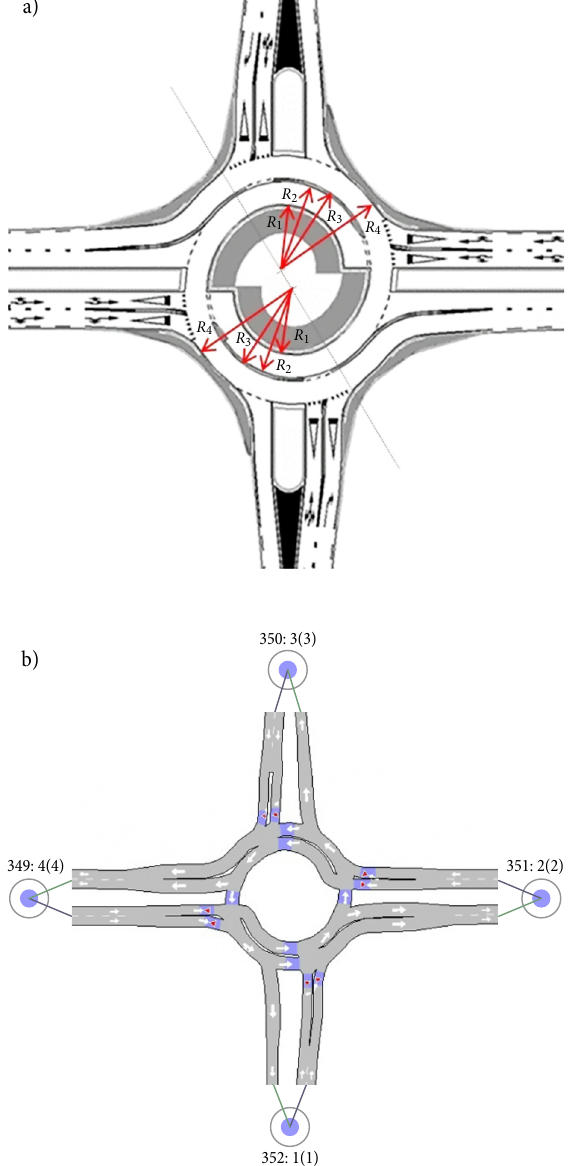
Fig. 2. Right lane capacity on minor entries: simulation vs Hagring